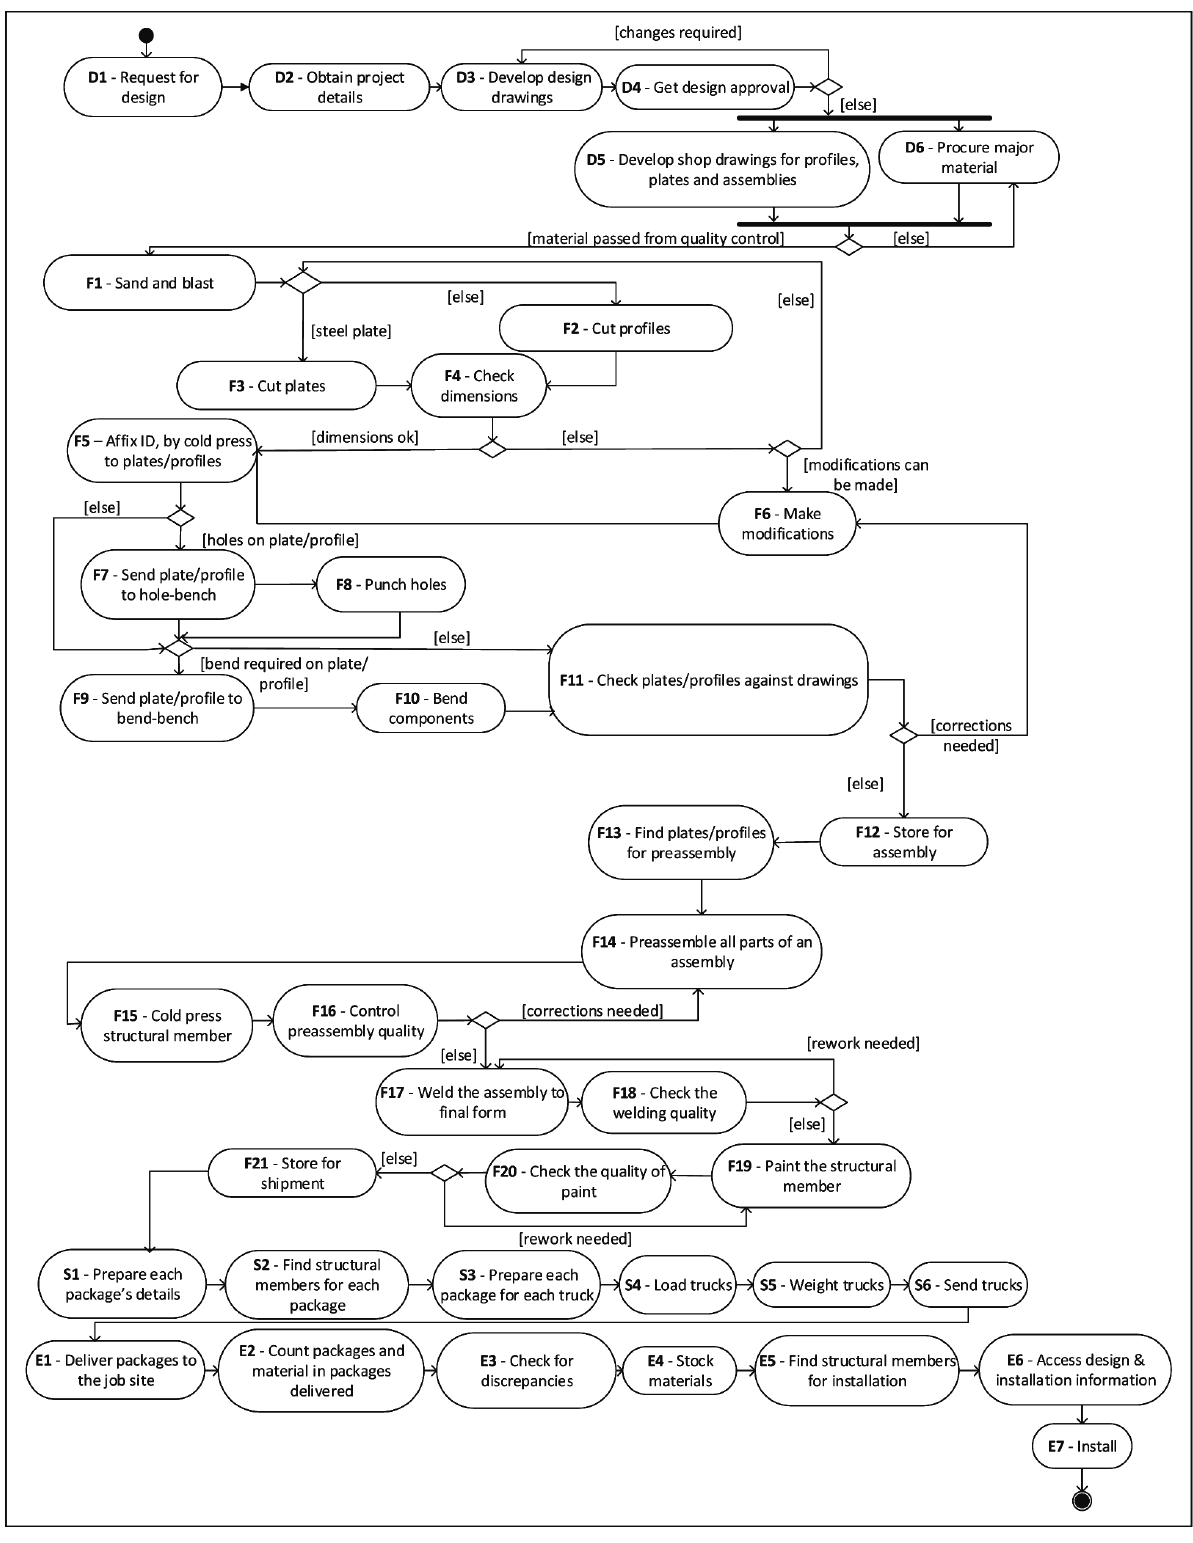
Fig. 2. UML activity diagram of process model for design, fabrication, shipment, and erection of structural steel